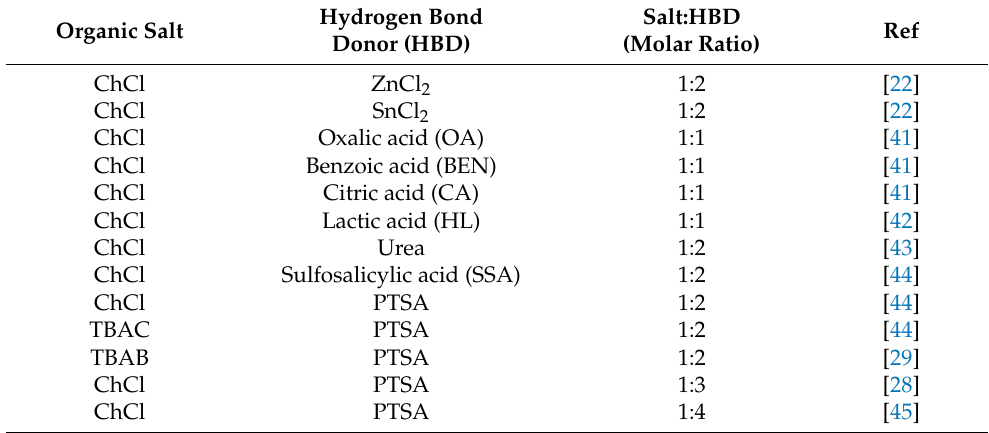
Table 4. Composition of